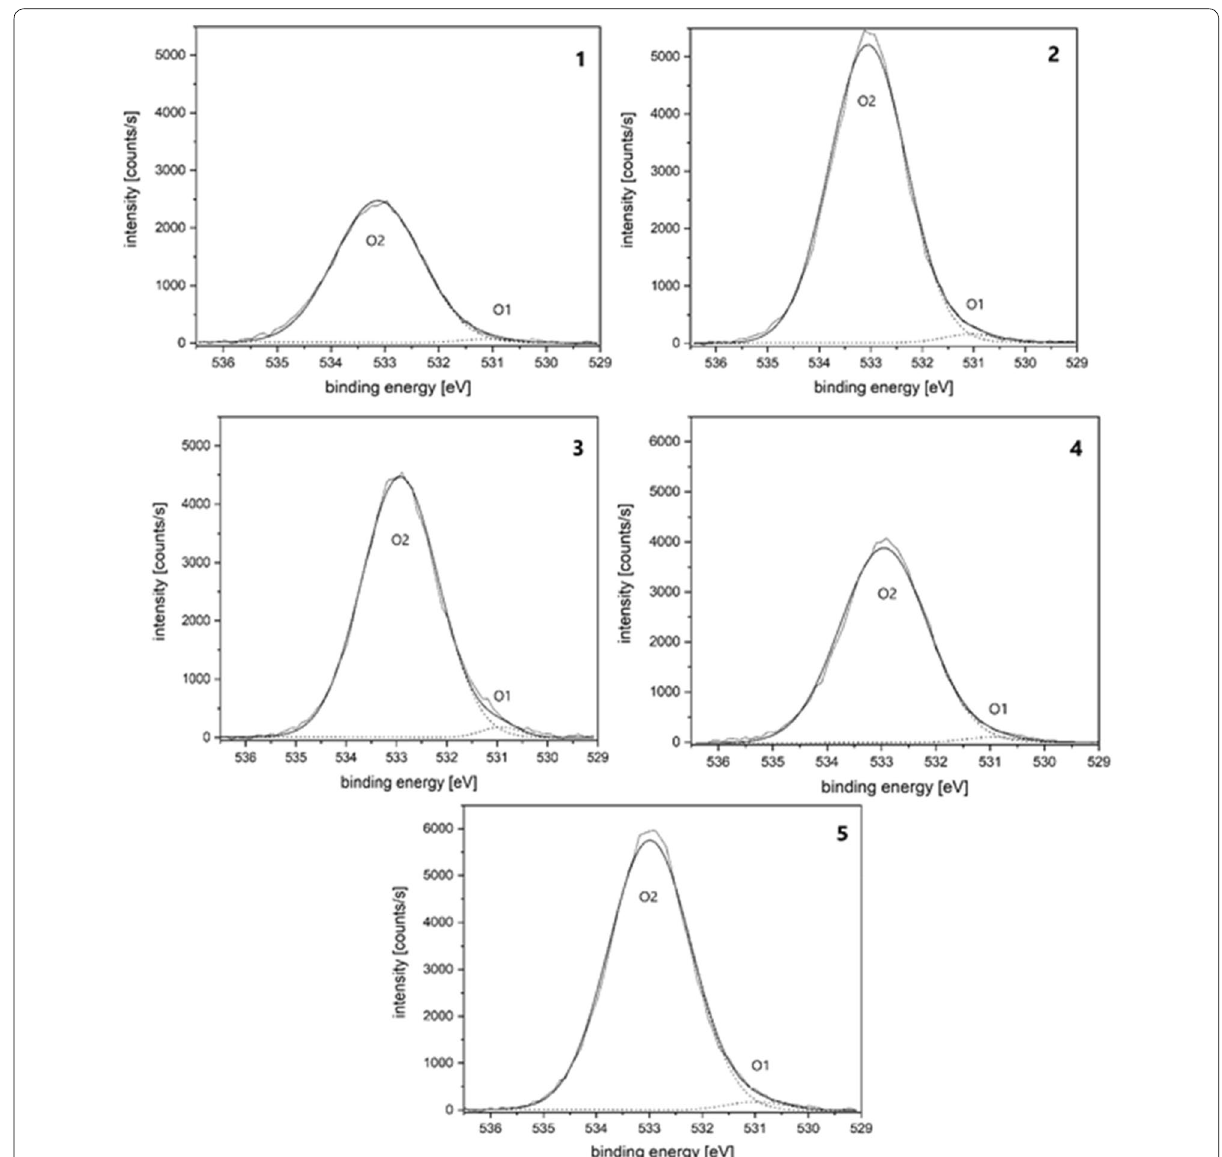
Fig. 4 High-resolution spectra of the O1s energy level of new spruce [ 1 ], aged spruce (a) [ 2 ], aged spruce (b) [ 3 ], new fir [ 4 ] and aged fir [ 5 ]